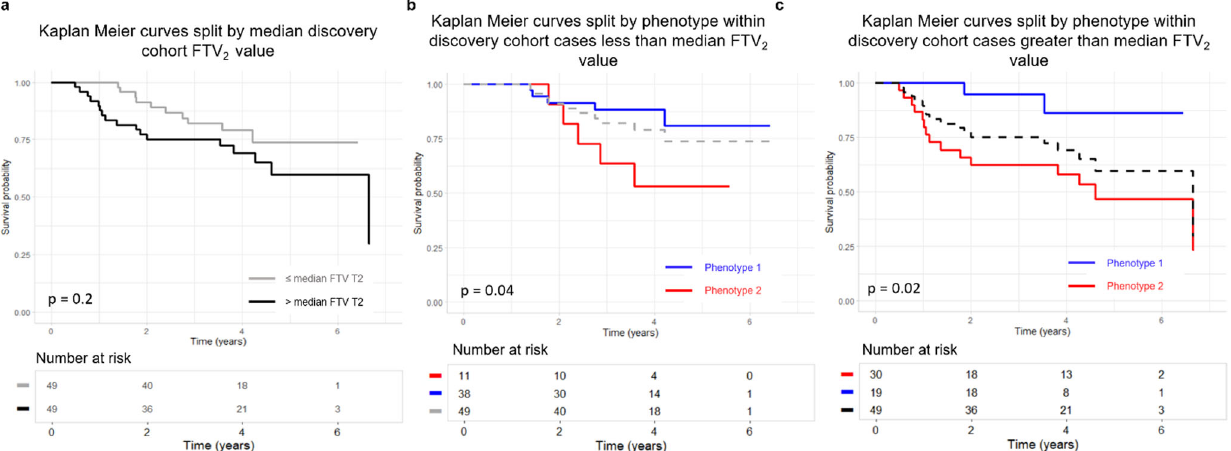
Fig. 3 Survival Analysis for the Discovery Cohort Split by Median Functional Tumor Value. Kaplan Meier recurrence free survival (RFS) curves for the discovery cohort split by median functional tumor volume at T2 (FTV 2 ) value ( n = 100) ( a ) versus split by phenotype within strata of less than median FTV 2 ( n = 51) ( b ) and greater than median FTV 2 ( n = 49) ( c ). RFS split by above/below median FTV 2 does not show p < 0.05 for separation. Within each stratum of FTV 2 , the split on phenotype is signi fi cant ( b and c